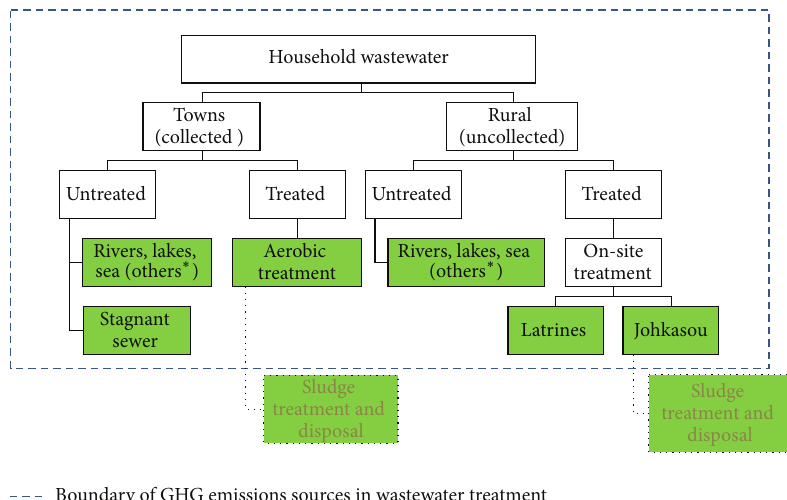
Figure 7: System boundary and wastewater treatment pathways. ∗ refers to the term ”others” as indicated in Table 3